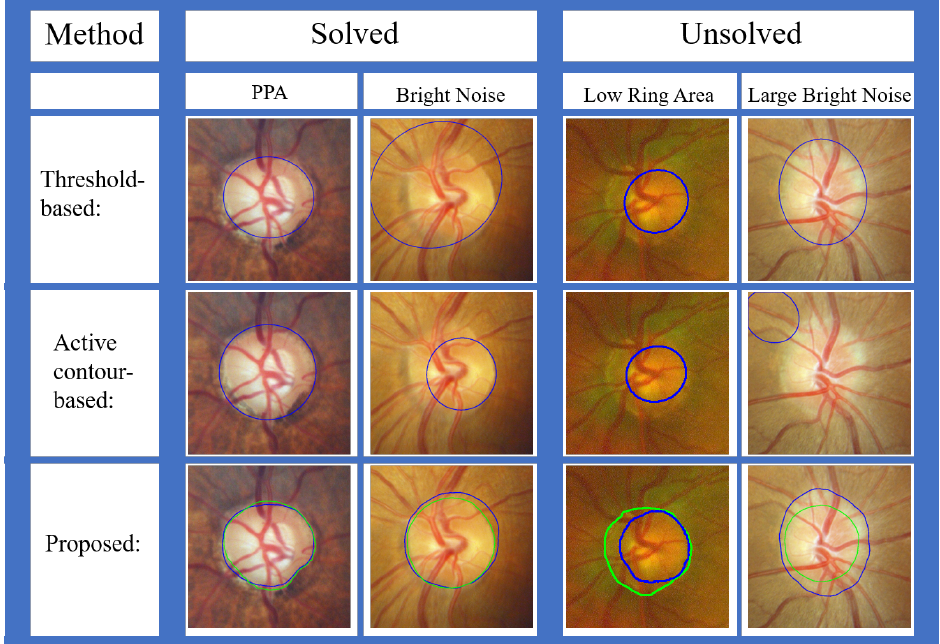
Figure 26. Comparison of some representative cases (green contour: GT, blue contour: segmenta- tion